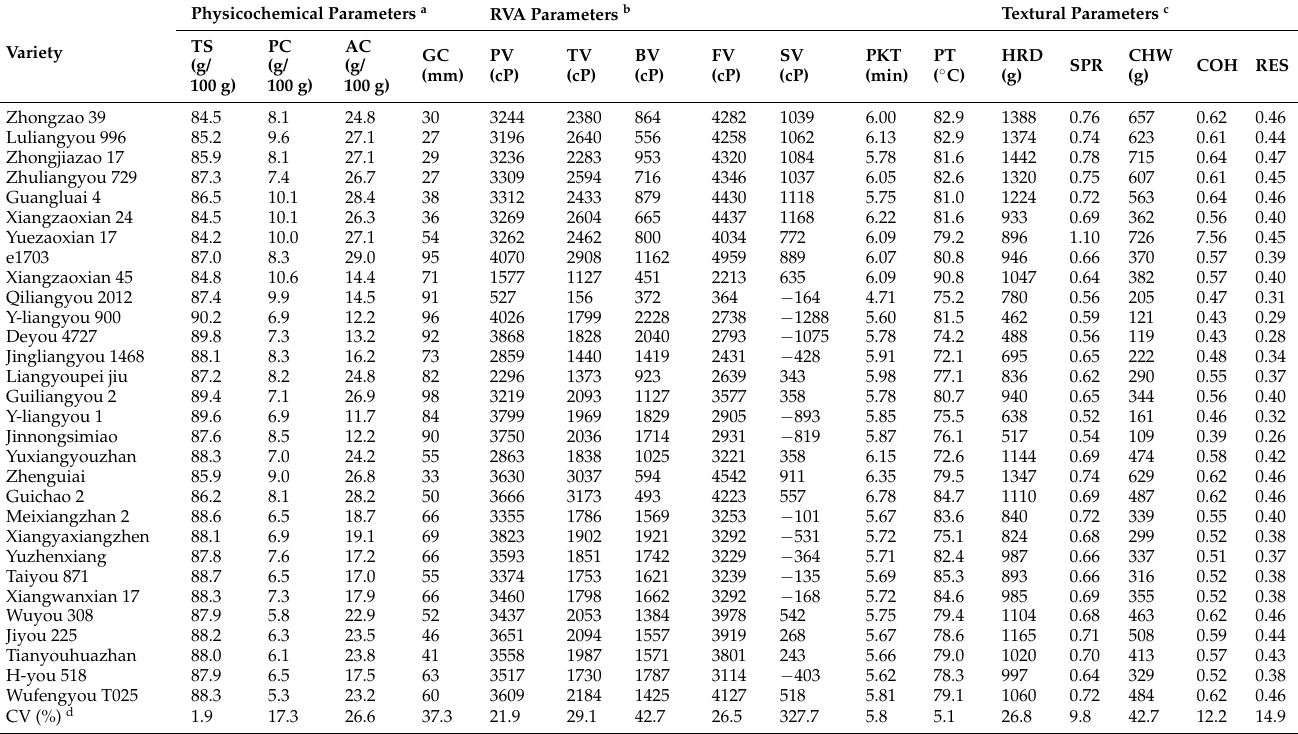
Table 1. Physicochemical, pasting and textural parameters of 30 rice